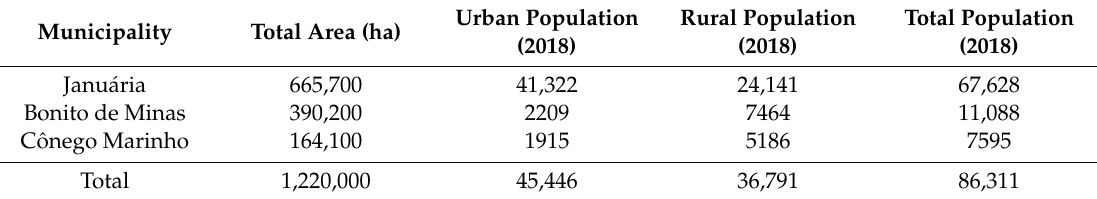
Table 1. Area and population living in the municipalities of Pandeiros River basin. Source: Brazilian Institute for Geography and Statistics. The population numbers refer to 2018.